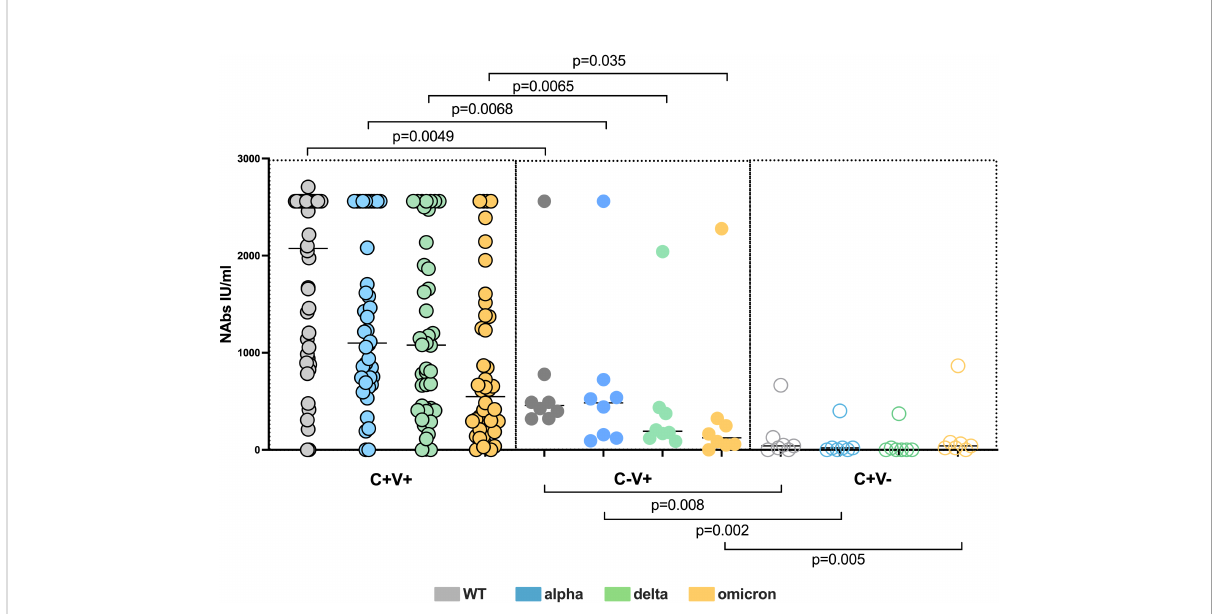
FIGURE 1 Superior humoral SARS-CoV-2 response among C+V+ and C-V+ against all VOC compared to C-V+. Comparison of WT, alpha, delta and omicron NAb titers among C+V+, C-V+ and C+V- study subjects. Scatterplots show line at median. Unpaired data were compared with Mann- Whitney-test. The assay detection limit for ND50 is 20. P<0.05 was considered signi fi cant, only signi fi cant p values are documented in the fi gures. To simplify the fi gure and the data presentation the signi fi cant results among C+V+ and C+V- are not documented in the fi gure (Results section